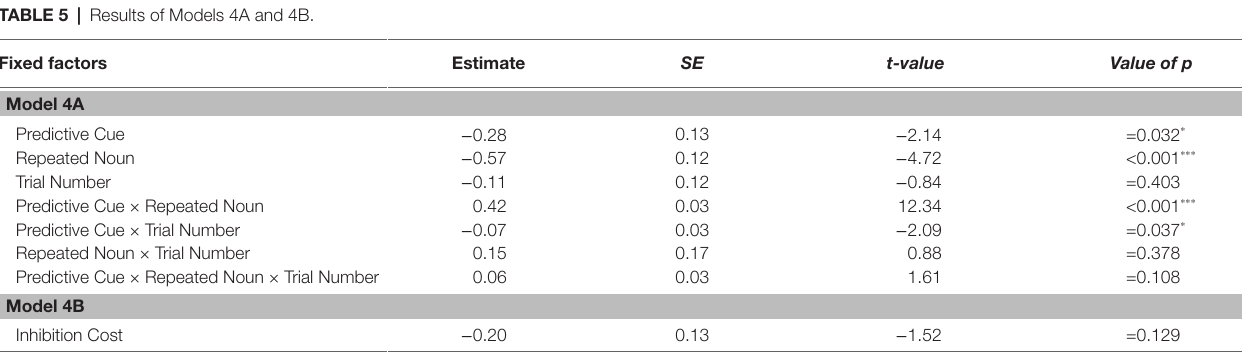
TABLE 5 | Results of Models 4A and